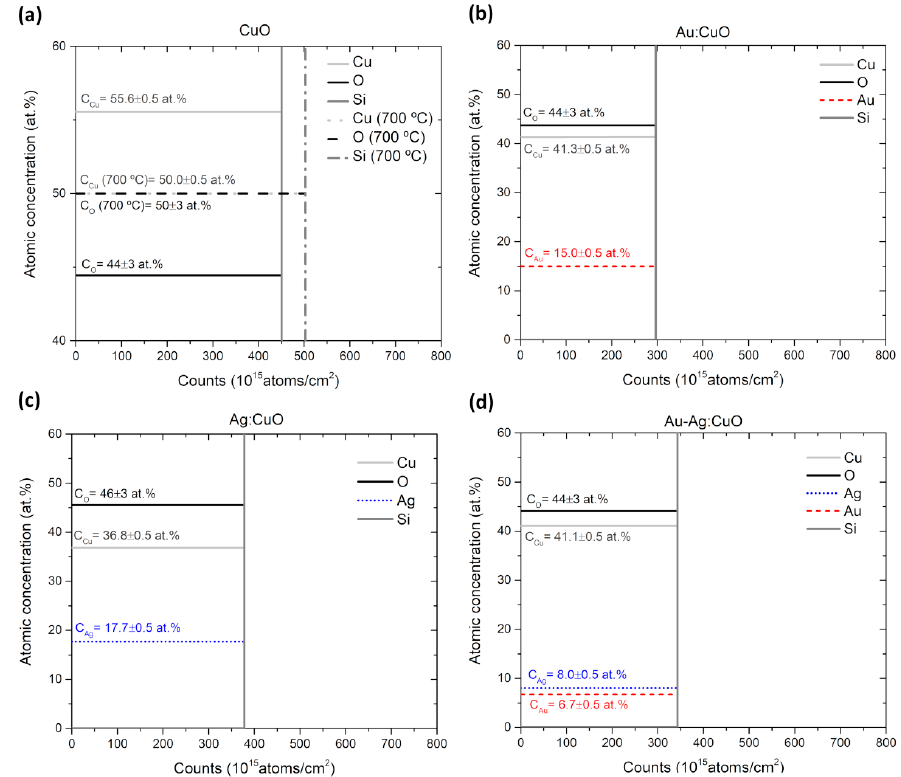
Figure 2. Atomic concentration (at.%) of the different elements present in the as-deposited CuO matrix (solid lines ( a )), in the CuO matrix with annealing at 700 °C (dash lines ( a )), and in the as-deposited samples of Au:CuO ( b ), Ag:CuO ( c ), and Au-Ag:CuO ( d ) films deposited with a pellets’ area of 960 mm 2 , obtained by the RBS data analyzed with the code IBA DataFurnace NDF v9.6i [43].